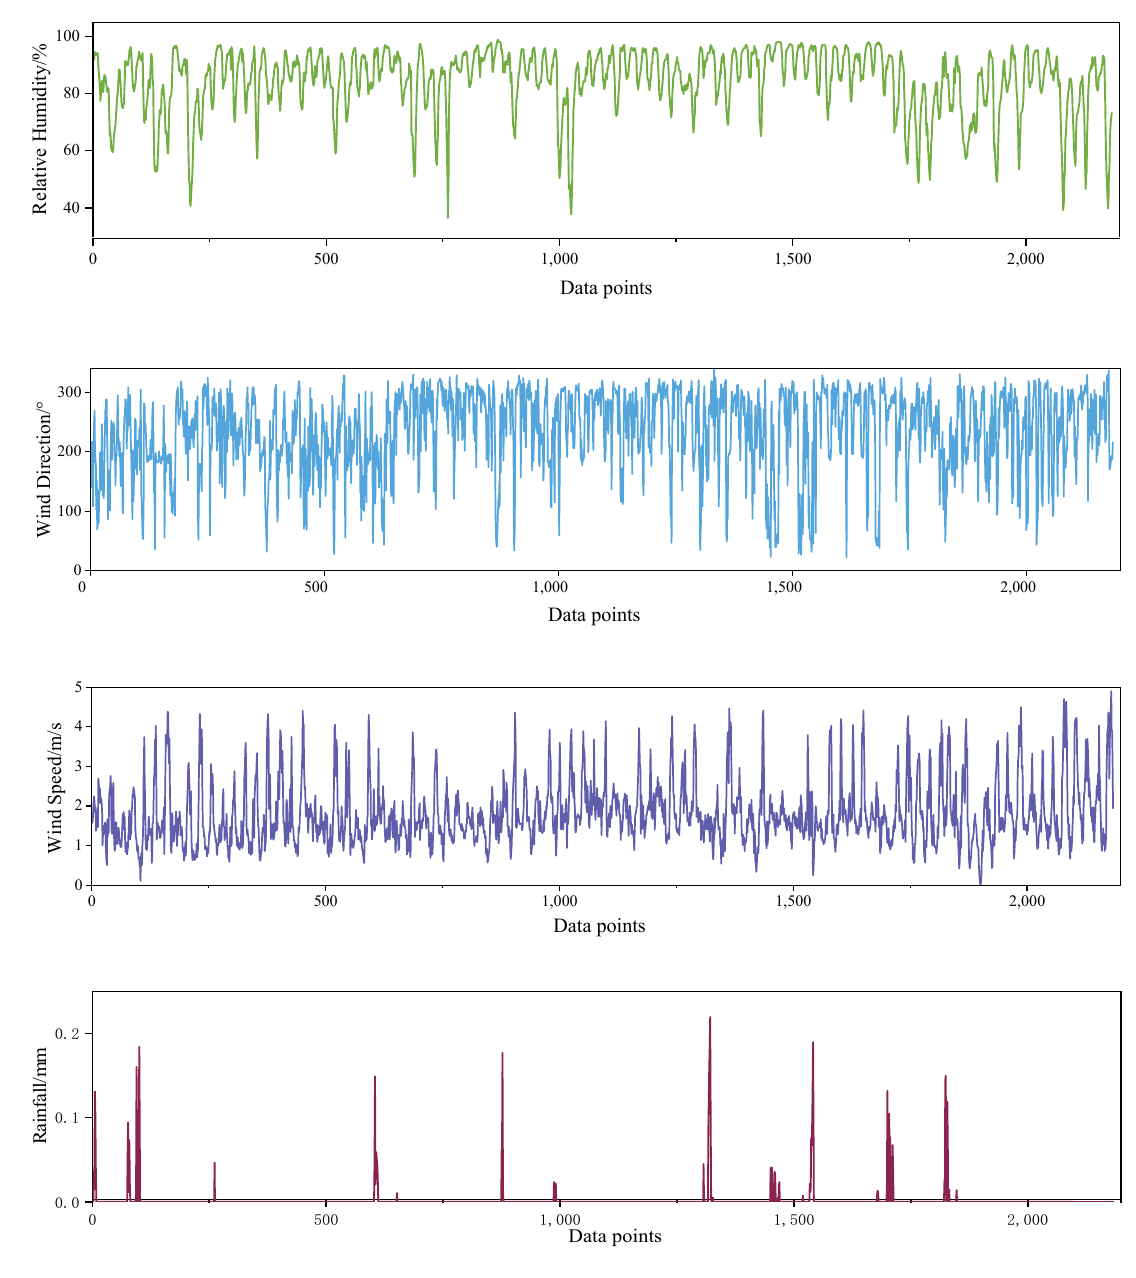
Figure 2. Distribution of each measured variable. Pavement temperature ( first ), air temperature ( second ), visibility ( third ), relative humidity ( fourth ), wind direction ( fifth ), wind speed ( sixth ) and rainfall ( last ). Table 2. Descriptive statistics of the climatic data and pavement temperature data.